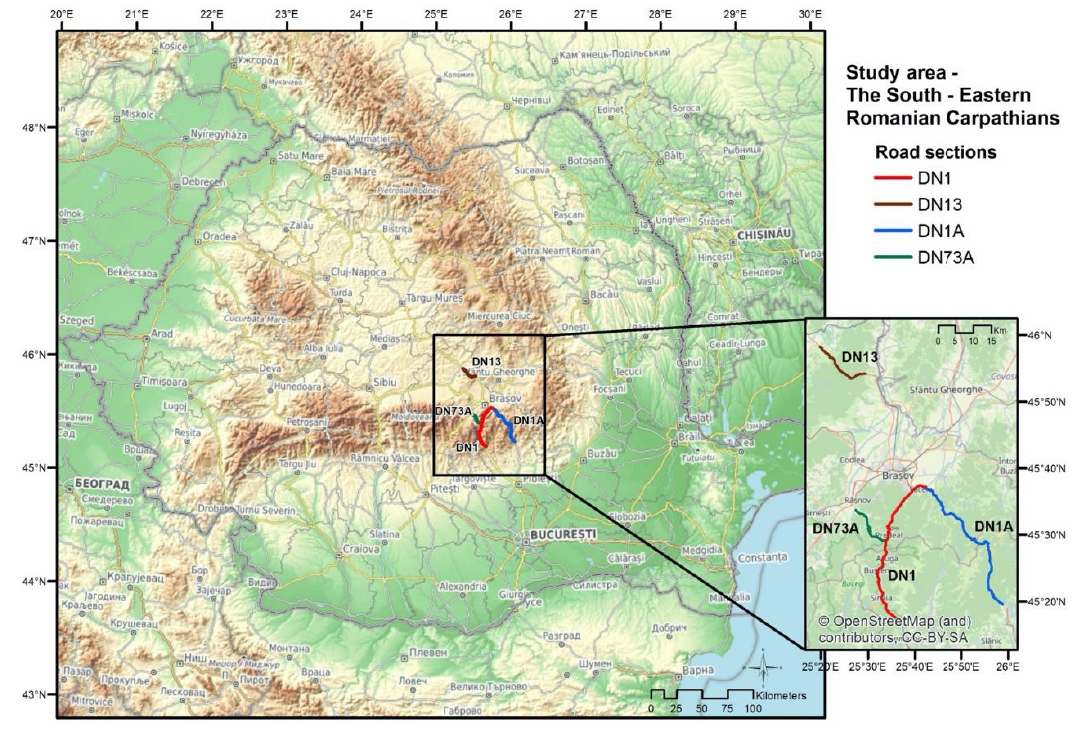
Figure 1. Study area in the Southern Eastern Romanian Carpathians and the roads’ location ( DN1 — red; DN73A — green; DN1A — blue; DN13 — yellow).